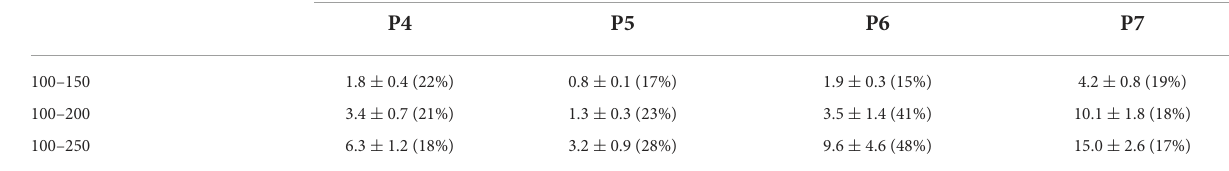
TABLE 2 Mean estimated intrinsic background doses and standard deviations (SD) on the surface of four screen protectors for three temperature intervals. ◦ Temperature interval (